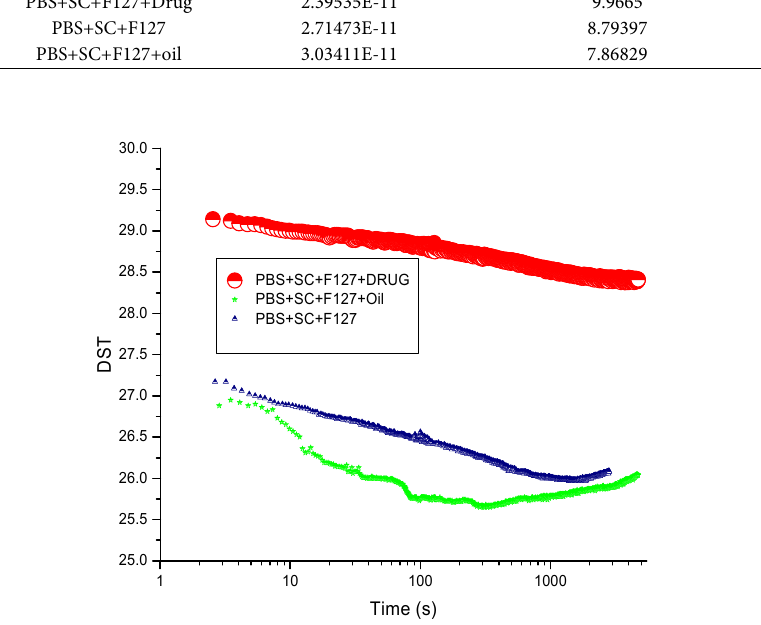
Fig. 11. surface tension of different mixtures with time from up to bottom: solution of F127, SC, drug in PBS, solution of F127, SC, oil in PBS, and solution of F127, SC in PBS.